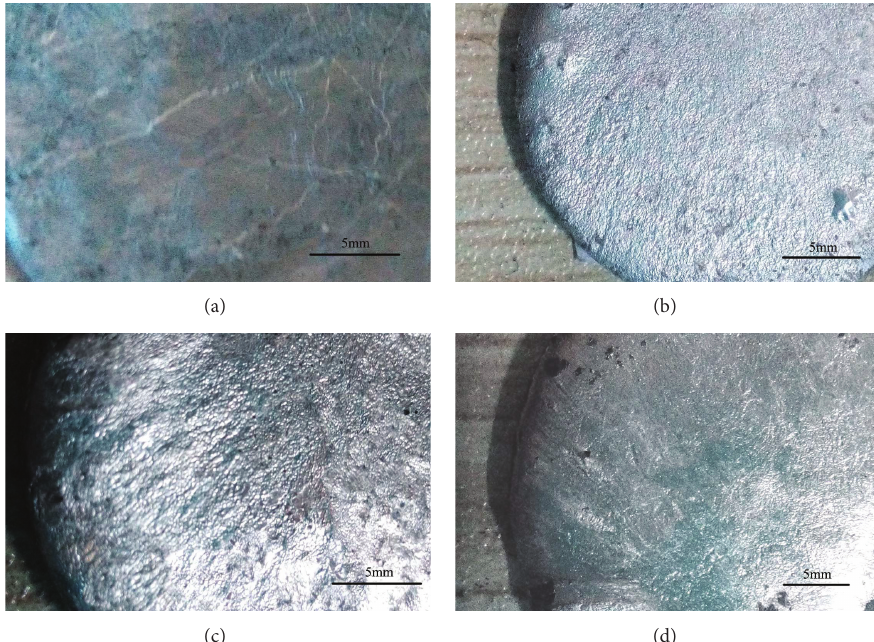
Figure 1: Oxidation appearances of (a) Sn-58Bi, (b) Sn-40Bi-2Zn, (c) Sn-40Bi-2Zn-0.005P, and (d) Sn-40Bi-2Zn-0.005Al after exposure in air at 170 ∘ C for